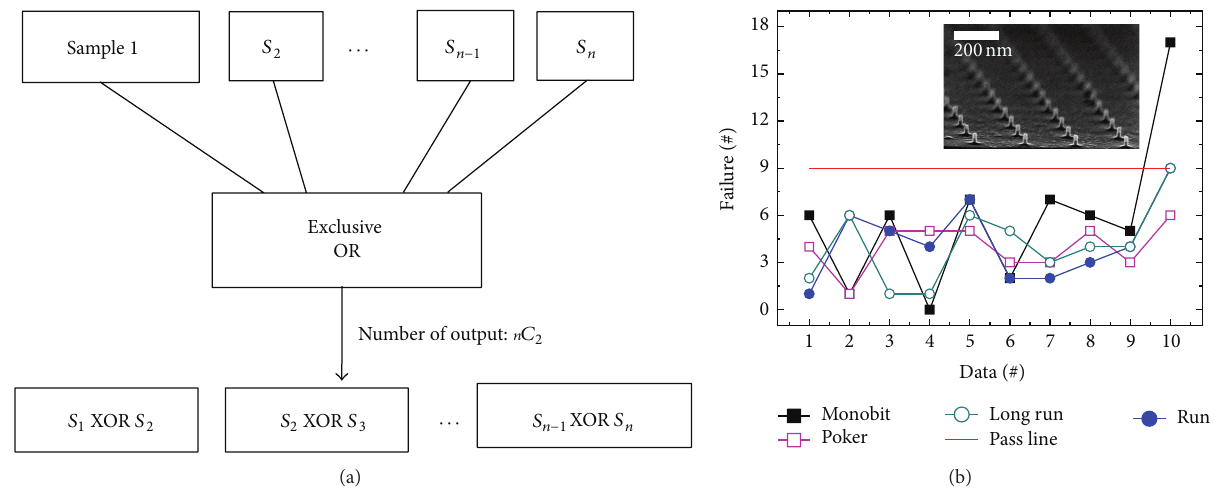
Figure 5: Generation of multiple random bits. (a) Schematic diagram of method for generating multiple random bits. Each signal is extracted after every XOR operation. The number of output signals follows the relation nC 2 , where C is combination. (b) The evaluation of the random bits generated simultaneously in five 30 nm pMTJ pillars. The XOR data measured for five cells are 10 in number (5 C 2 ); their numbers are indicated on the 𝑥 -axis of the graph. (Inset) SEM image of the pMTJ array with 30 nm junction and 200 nm